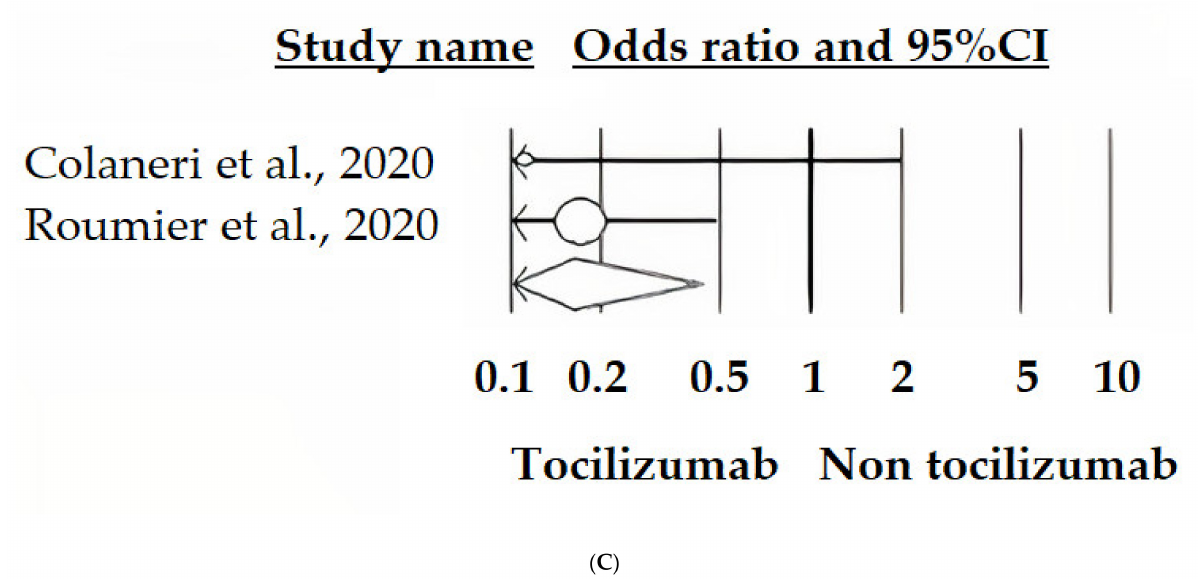
Figure 4. ( A ) Random-effects model forest plot of the impact of tocilizumab on ICU admission rate in cases receiving tocilizumab plus standard care versus controls not receiving tocilizumab, according to studies reporting unadjusted estimates (crude events). It shows a high amount of heterogeneity among studies and no effect of tocilizumab on ICU admission rate. ( B ) Funnel plot of the random-effects model of the impact of tocilizumab on ICU admission rate in cases receiving tocilizumab plus standard care versus controls not receiving tocilizumab, according to studies reporting unadjusted estimates. It shows no evidence of publication bias. ( C ) Fixed-effects model forest plot of the impact of tocilizumab on ICU admission rate in cases receiving tocilizumab plus standard care versus controls not receiving tocilizumab, according to studies reporting adjusted estimates. It shows no heterogeneity among studies and a protective effect of tocilizumab on ICU admission